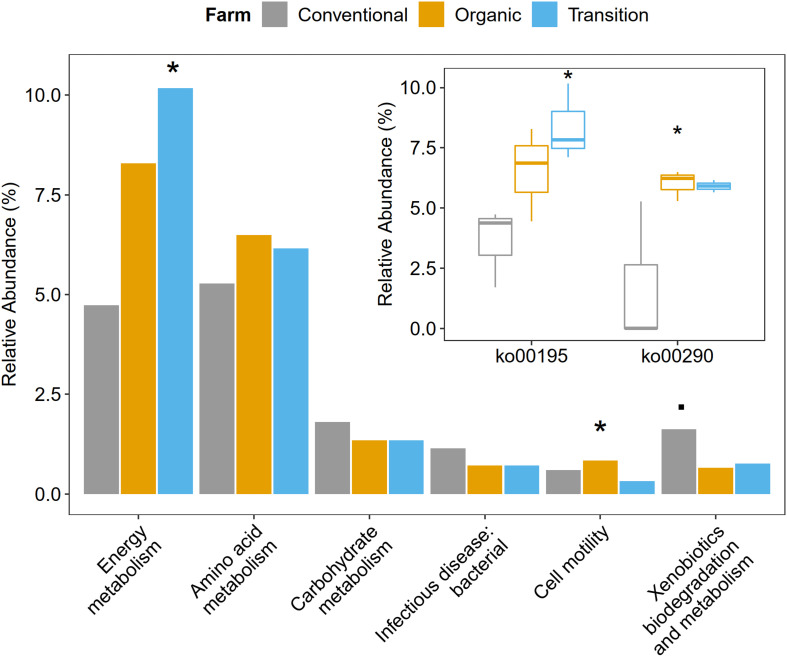
The impacts of farming practices on metabolic processes at the second and third levels of KEGG hierarchy. The statistical test was performed using one-way ANOVA in which p-values < 0.05 were considered significant as represented by the (*) symbol, while the (.) character reflected p-value < 0.1.